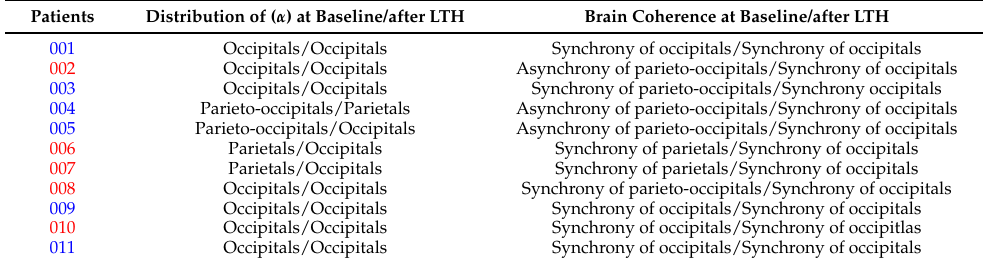
Red represents patients who used filters transmitting long-wavelength light (red-orange-yellow) and blue the patients who used filters transmitting low-wavelength light (from bright to dark blue and the combination of grey-blue and violet-blue). Filters transmitting medium-wavelength light (green) are stabilizing filters and were combined either with red or blue filters according to the needs of each patient. EEG recordings were carried out in the waking-state. ( α ), alpha-wave; LTH, light